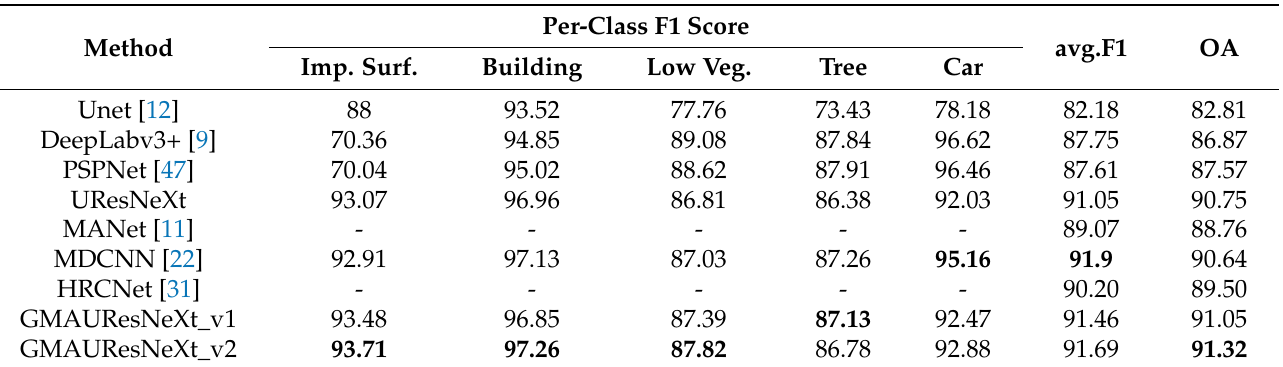
Table 1. The experimental results on the ISPRS Potsdam dataset. (Imp.Surf.: impervious surface; Low Veg.: low vegetation).